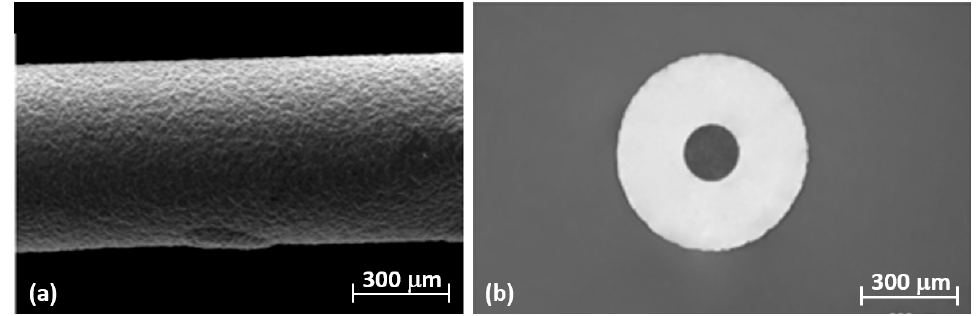
Figure 4. Micrographs of ( a ) super fi cial appearance and ( b ) cross section of Ni-coated fi ber.